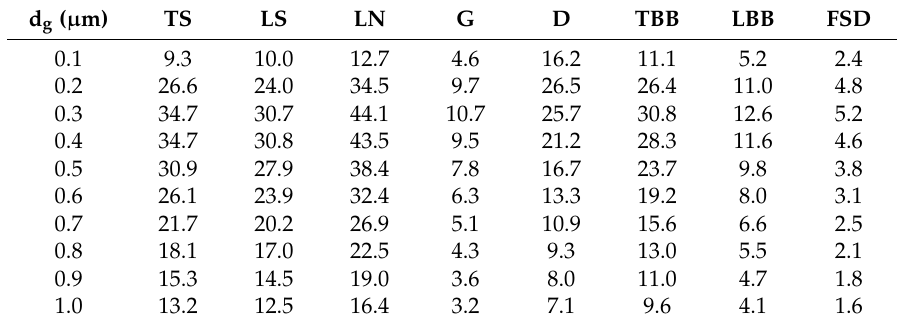
Table 3. Source-based extinction coefficients ( b ext , Mm − 1 ) for different geometric mean diameters (geometric standard deviation =